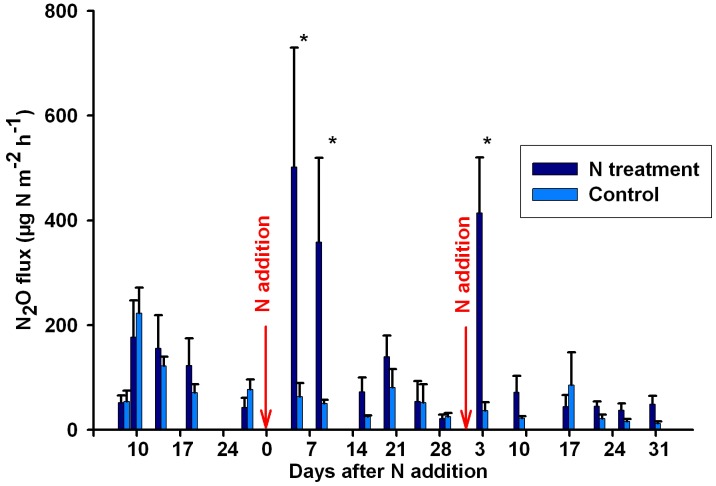
Effects of N addition on N2O fluxes (n = 3).Arrows represent N addition on that date. Error bars are standard errors. * represents significant effect at p = 0.05.